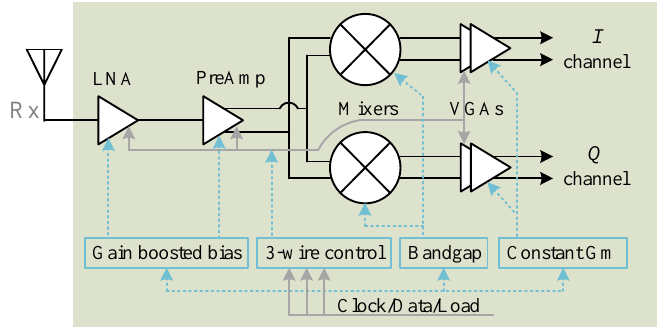
Figure 14. Simplified block diagram of the 5 GHz software-configurable Doppler radar sensor.